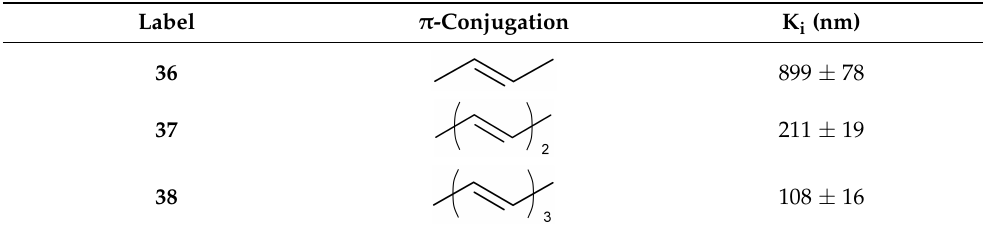
Table 5. Inhibition constants of [Cp 99m Tc(CO) 3 ]-chalcone-mimic derivatives against [ 125 I] IMPY as adapted from